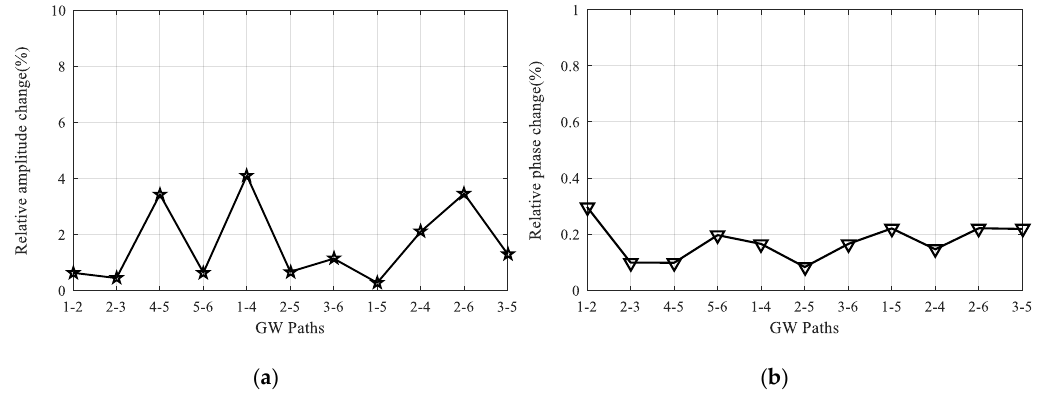
Figure 13. Relative signal change of all the paths after vibration tests. ( a ) Relative amplitude change. ( b ) Relative phase change.